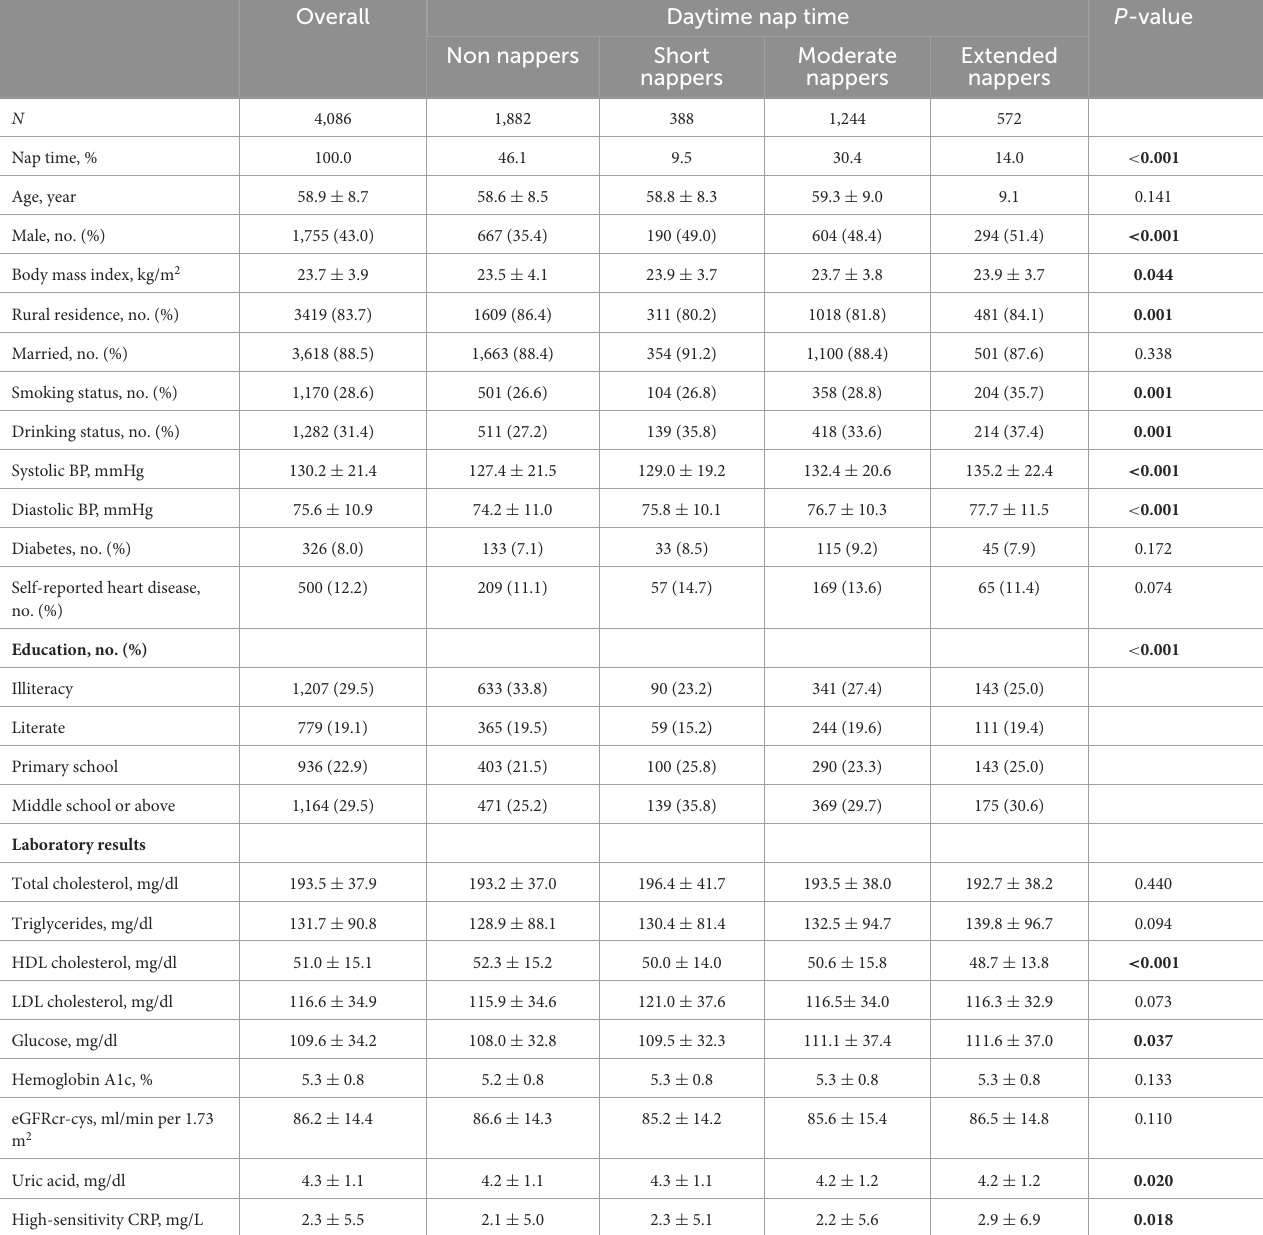
TABLE 2 Participants ( n = 4,086) characteristics by daytime nap categories. Overall Daytime nap time P -value Non nappers Short Moderate nappers